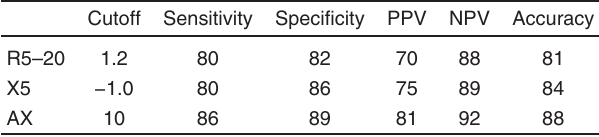
Table 4 Sensitivity and specificity of impulse oscillometry